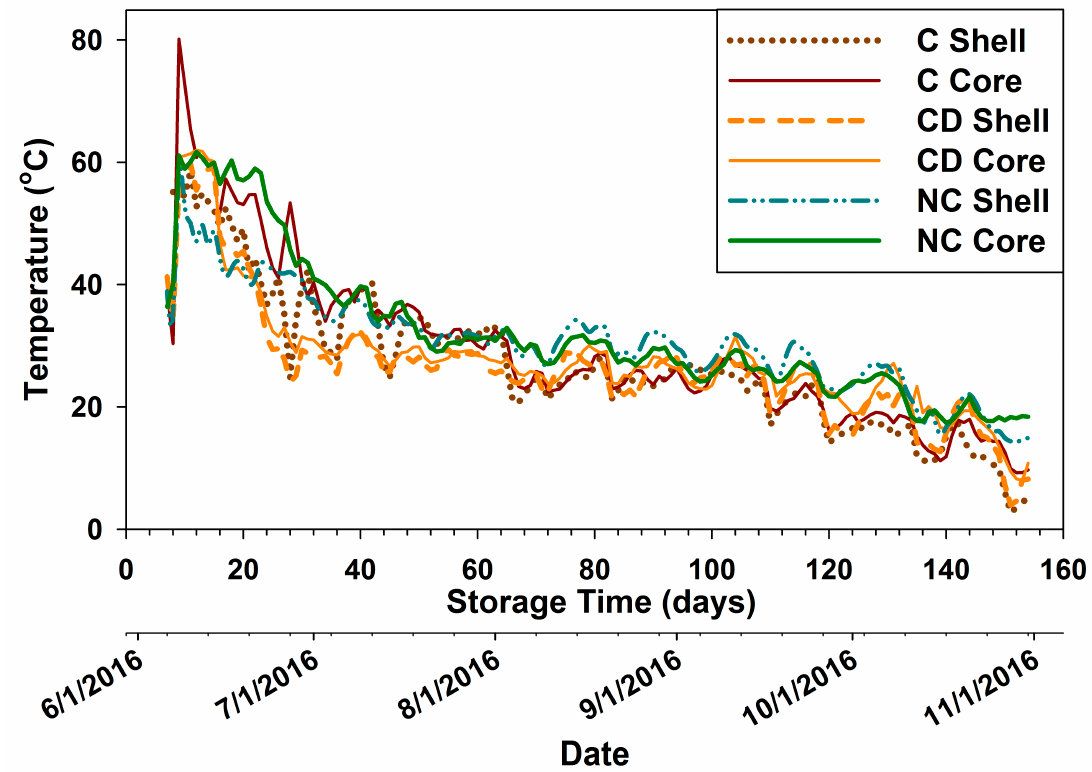
Figure 3. Daily mean temperature in the core (about ½ depth) and shell (<45-cm depth) of C, NC, and CD piles of willow and poplar wood chips (NC—no cover on pile; C—covered pile; CD—covered pile with dome ventilation).